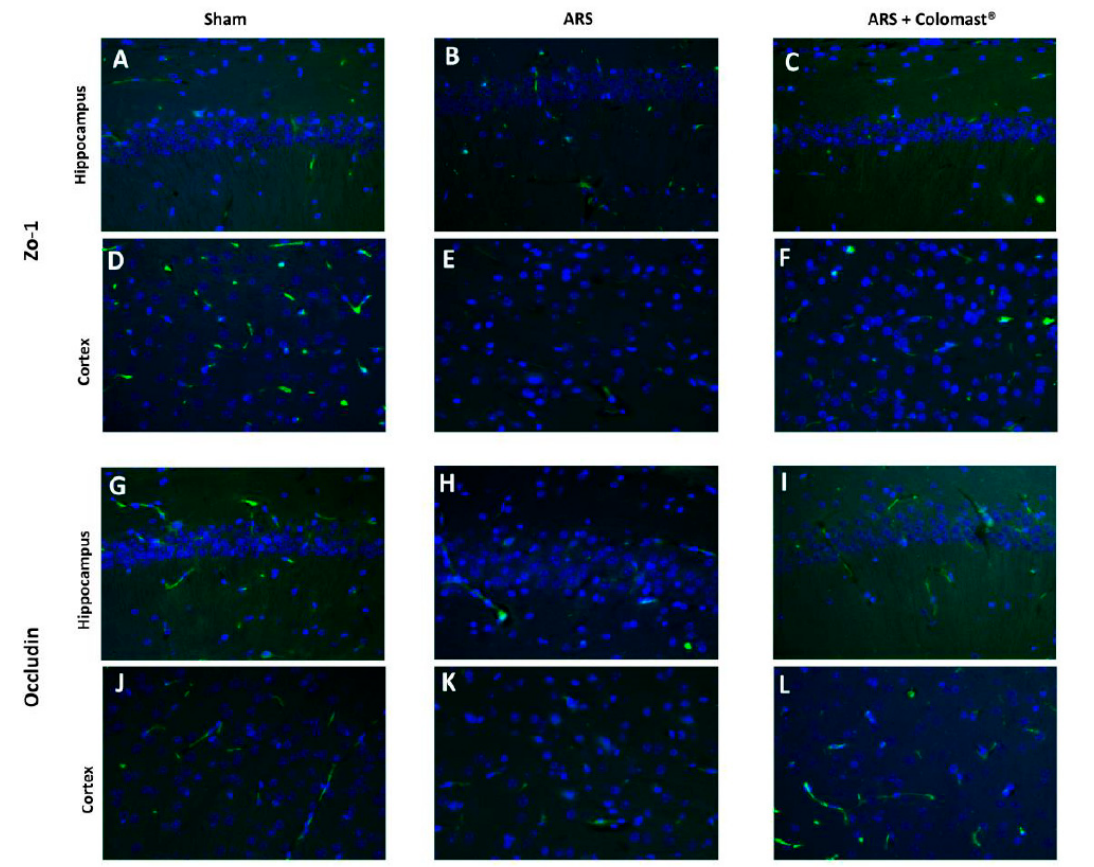
Figure 9. Effect of Colomast ® pre-treatment on tight junction expression in the brain. Immunofluorescence of ZO-1 in hippocampus and cortex respectively: sham ( A , D ); ARS ( B , E ); Colomast ® ( C , F ). Immunofluorescence of Occludin in hippocampus and cortex respectively: sham ( G , J ); ARS ( H , K ); Colomast ® ( I , L ). Images are figurative of at least three independent experiments. Values shown are means ± SEM of six animals in each group. For the immunofluorescence, a 40× magnification is shown (75-µm scale bar).